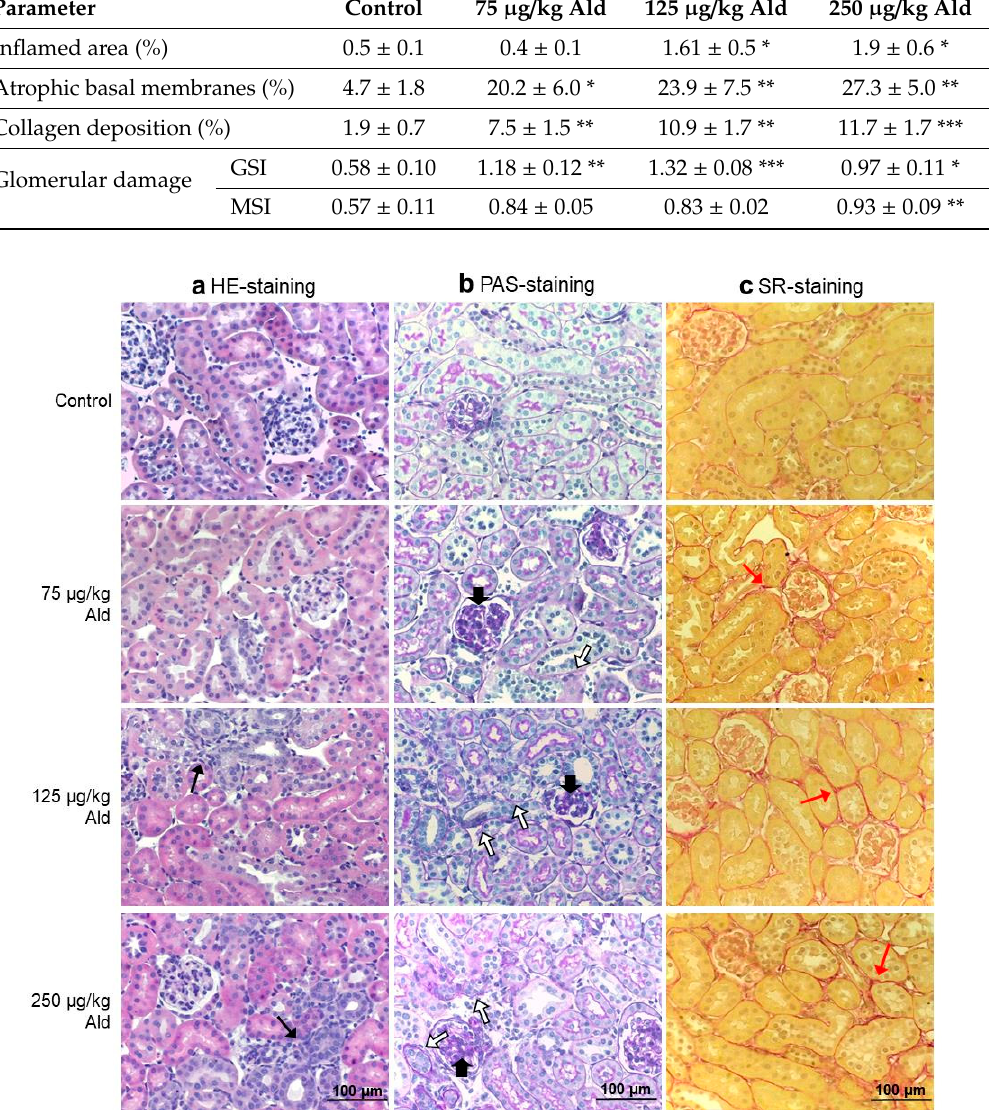
Table 2. Quantification of morphological changes. For every staining 18 visual fields or 30 glomeruli per animal were analyzed under the microscope. Ald: aldosterone, GSI: glomerular sclerosis index, MSI: mesangiolysis index. Data are shown as mean ± SEM, n = 4–5. * p ≤ 0.05, ** p < 0.01, *** p < 0.001 vs. control group.